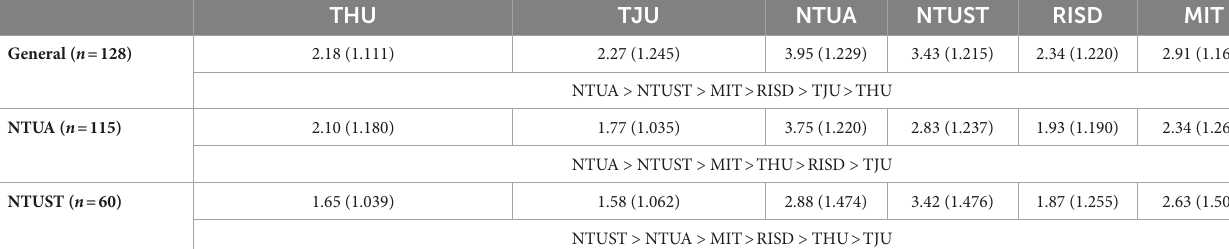
TABLE 4 The mean and standard deviation of subjects’ familiarity with six universities.